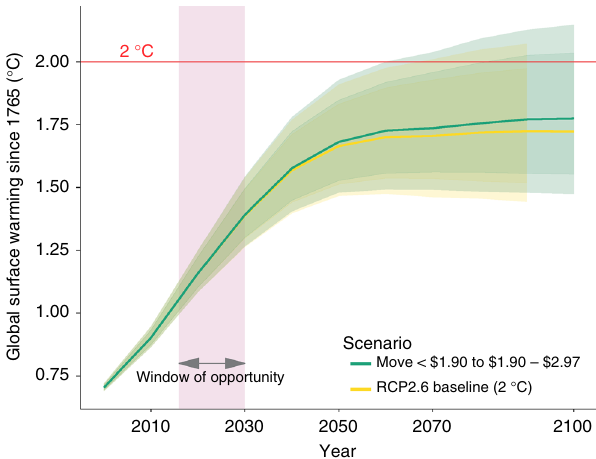
Fig. 2 Predicted increases in global temperature of different scenarios dealing with extreme poverty. Move extreme poor < 1.90$ PPP per day above extreme poverty level. The green line shows the warming determined by ending extreme poverty over the baseline (yellow line). 50% (dark shading) and 66% (light shading) con fi dence ranges are obtained in MAGICC by running the model 600 times each time using a slightly altered set of climatic parameters that are based on historical